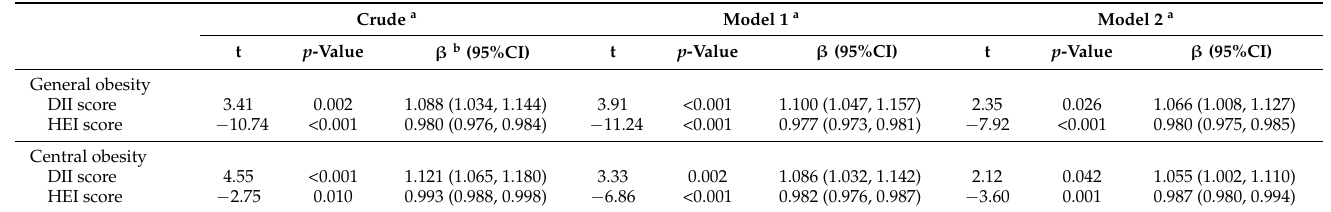
a Calculated using logistic regression. Model 1 adjusted for age and gender. Model 2 adjusted for age and gender, race/ethnicity, education, marital status, poverty ratio, diabetes, work activities, recreational activities, hypertension, and smoking. b OR: odd ratio.